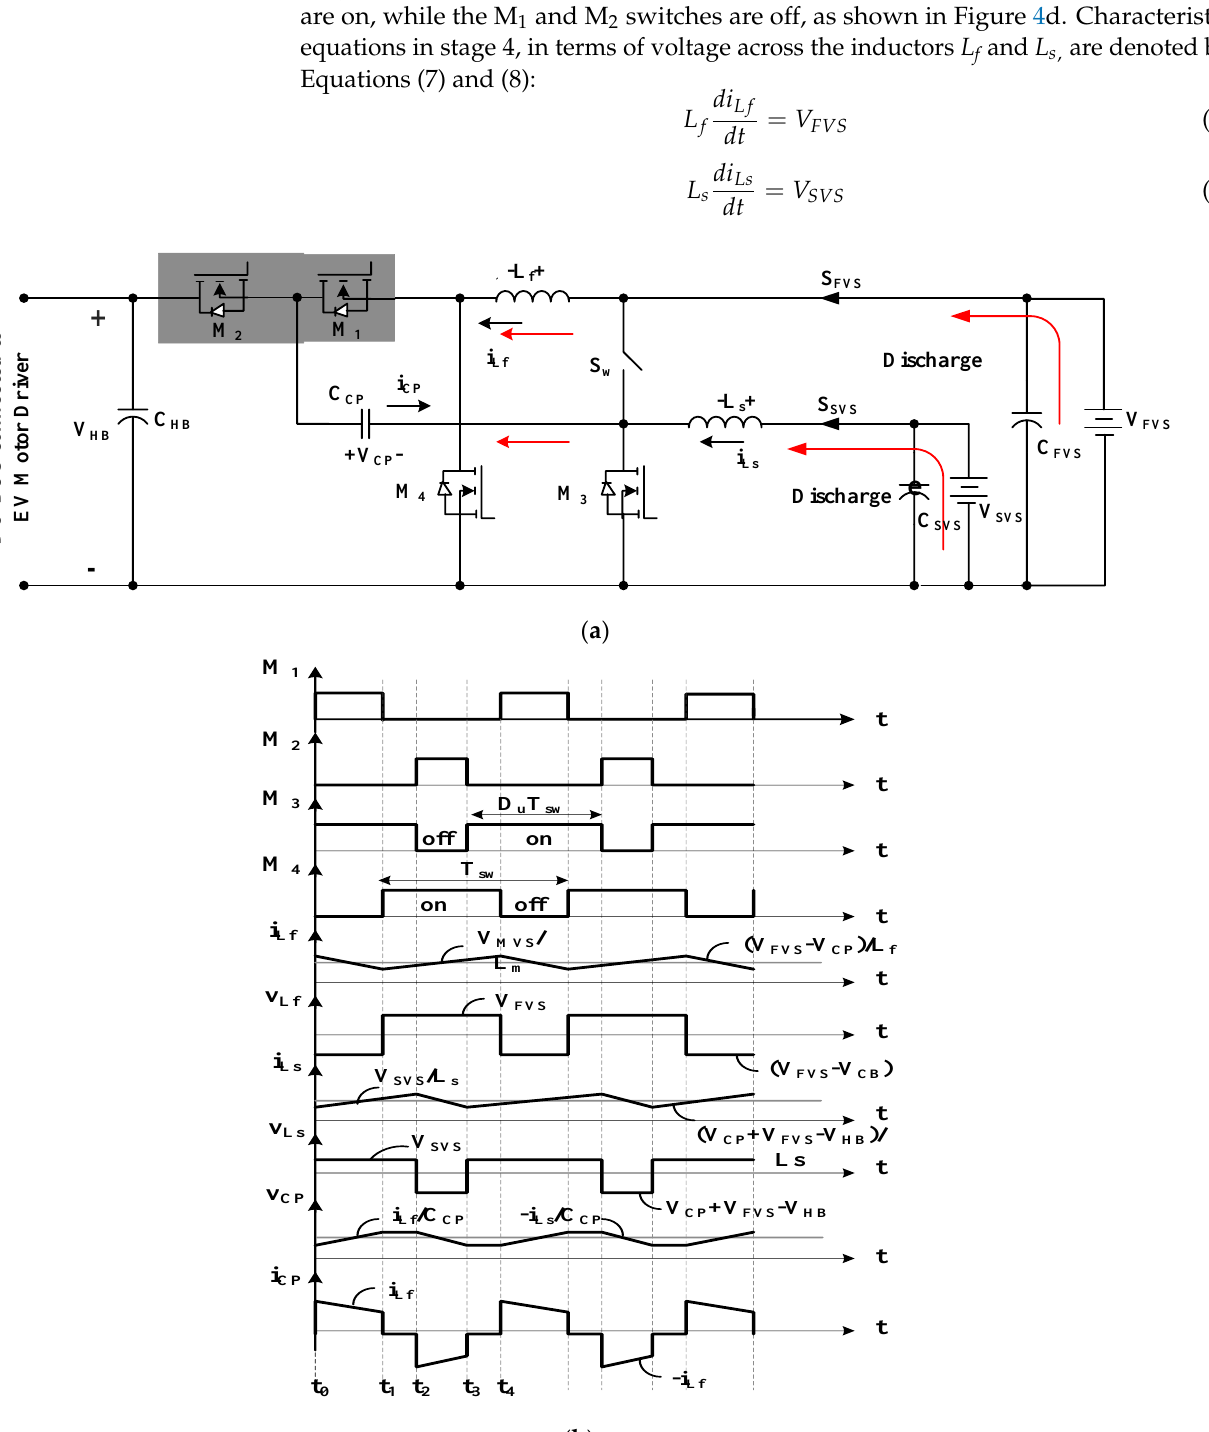
(d) Stage 4 [t 3 < t < t 4 ]: Time interval at this stage is (D t − 0.5)Ts. M 3 and M 4 switches Switches ( 𝑆 𝐹𝑉𝑆 𝑎𝑛𝑑 𝑆 𝑆𝑉𝑆 ) are turned ON. Dual low voltage sources ( 𝑉 𝐹𝑉𝑆 , 𝑉 𝑆𝑉𝑆 ) provide